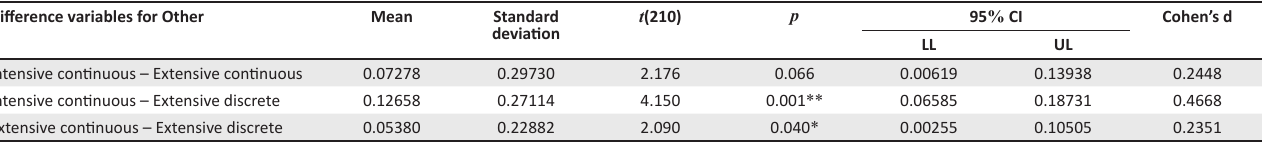
TABLE 7: Differences depending on the type of magnitude for the variable Other in the South African context. Difference variables for Other Mean